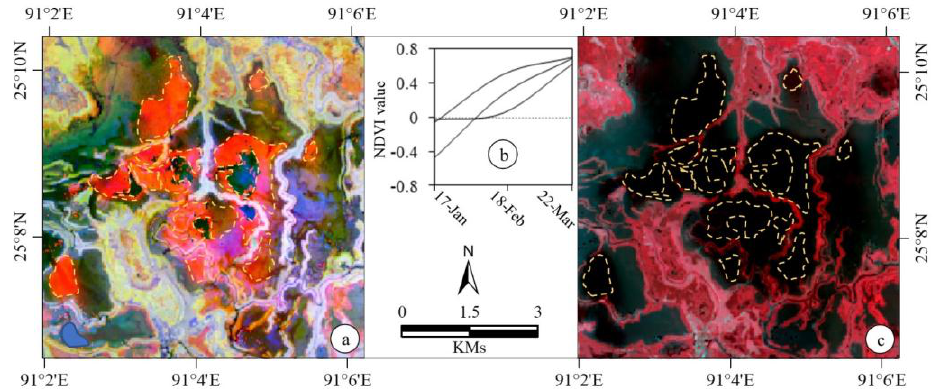
Figure 4. Example of misclassification of the portion of water bodies over north-west portion of the Sunamgonj district as boro rice as depicted using yellow dotted polygons on the multi-temporal (acquired on 17 January, 18 February, and 22 March 2017) NDVI images derived from Landsat-8 data (panel ( a )); its resultant multi-temporal NDVI signature ( b ). Also, these areas were, in fact, potion of waterbodies as shown using yellow dotted polygons on a false colour composite of the multi-spectral Landsat-8 data acquired on 22 March 2017 ( c ). In panel ( a ), redish, black to blueish, and yellowish colours show misclassified water bodies as boro , water bodies, and boro respectively. On the other hand, black to blueish, and redish colours in panel ( c ) show water boides, and boro respectively.